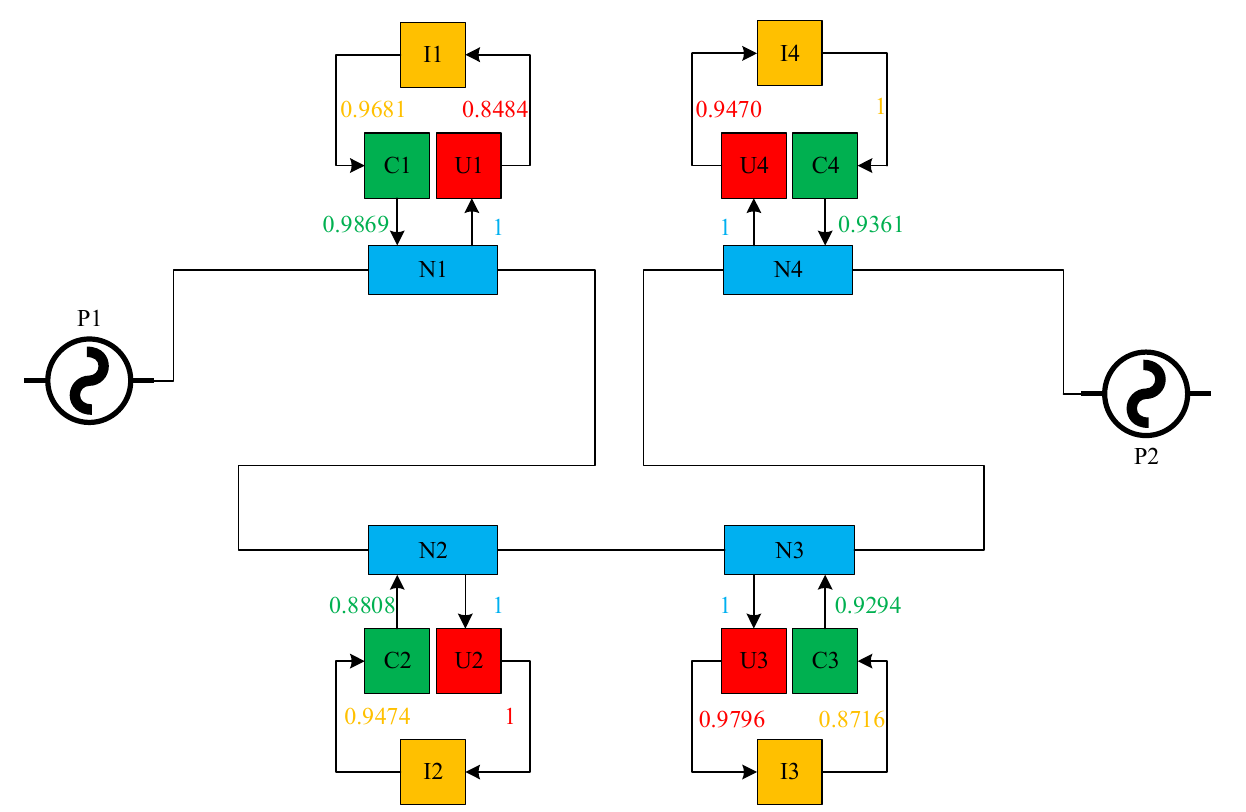
Figure 11. Complex network topology of a CPPS.